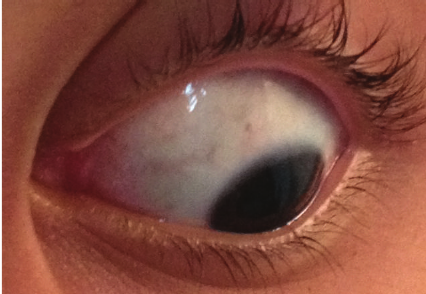
and redness at sites of old nodular lesions two months after presentation.